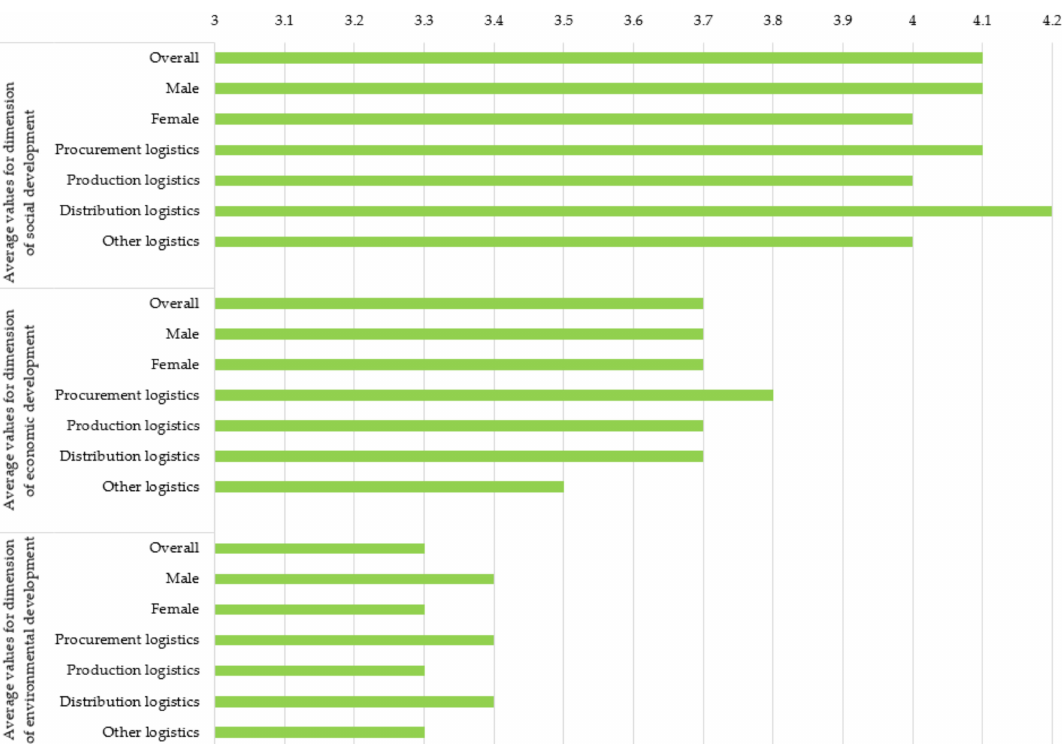
Figure 1. Average values of SD dimensions in sample enterprises (1 means a very low value, 5 means a very high value).